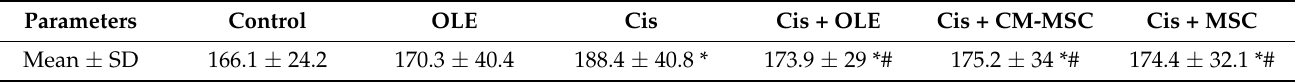
Table 7. The mean and standard deviation (SD) of the optical density of anticytokeratin immunoreac- tion activity in the reticuloepithelial cells of the thymus in the different experimental groups.